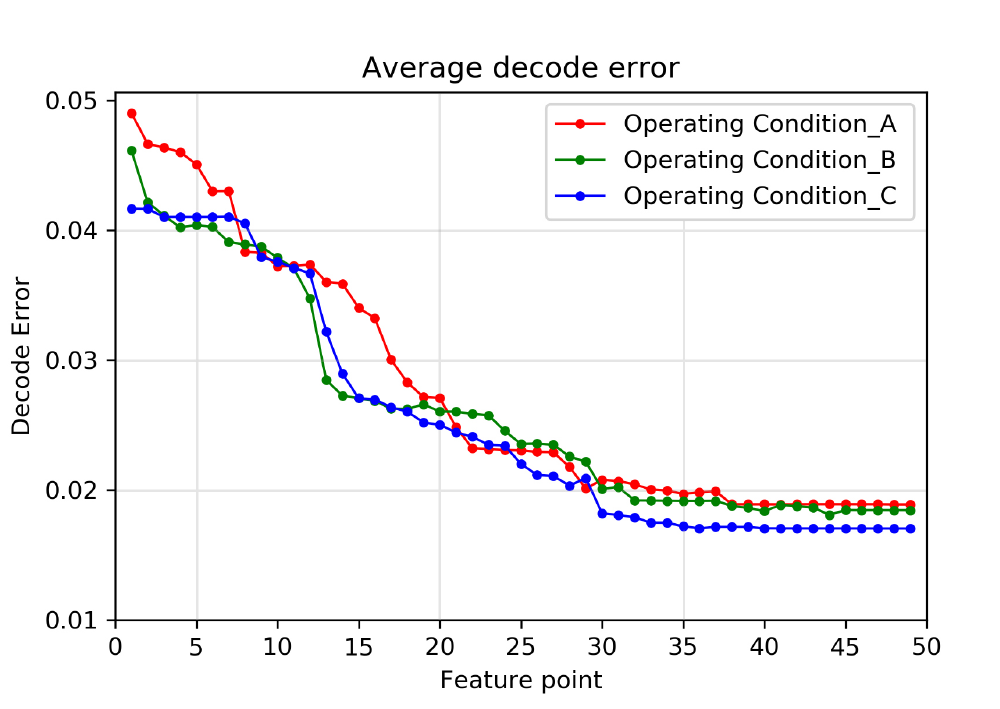
Figure 7. Visualization of training process-SDAE.